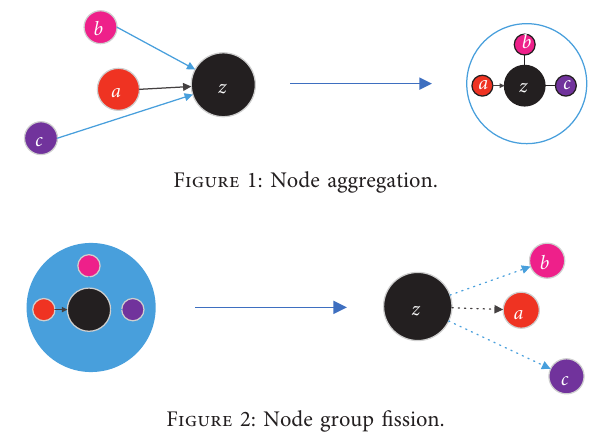
Figure 2: Node group